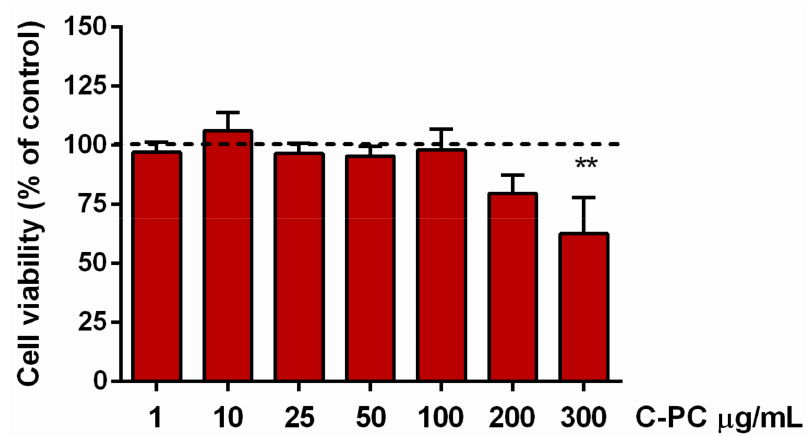
Figure 1. Effect of C-phycocyanin in microglia cell viability. Microglia were cultured overnight in medium containing 10% of serum, which was replaced with serum-free medium before exposure to C-PC (1–300 µ g/mL) for 16 h. At the end of incubation, SRB assay was used to measure cell viability. Results are expressed as percentage of cell viability relative to control cells. Data are means ± SEM of 3 independent experiments. ** p < 0.01 versus control cells (dashed line). One-way ANOVA followed by Holm–Sidak’s